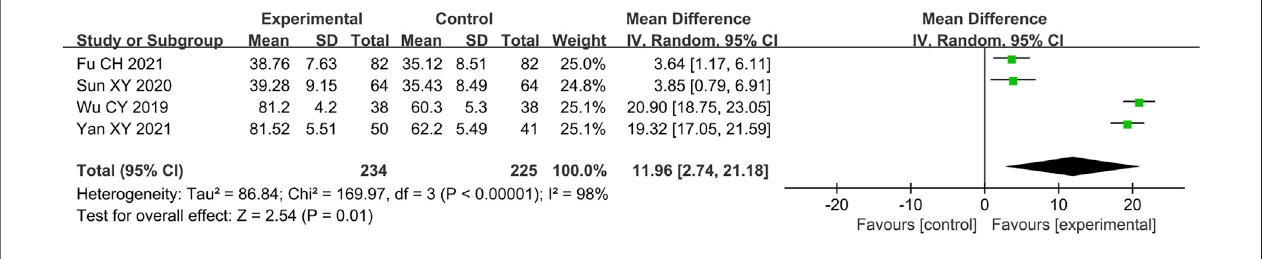
TABLE 5 | Subgroup analysis of hs-CRP based on treatment duration, average age, comorbidity and sample size. Criteria for grouping treatment duration